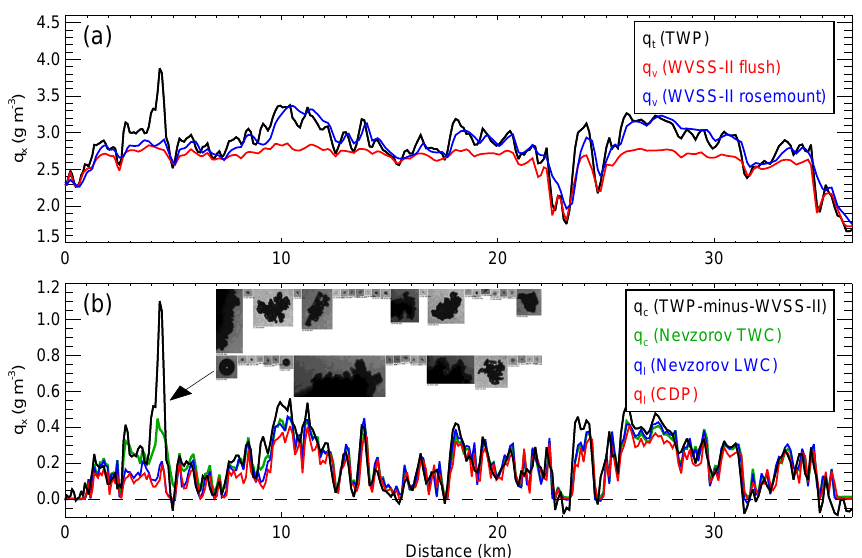
Figure 1. Example data from flight B668 in stratocumulus cloud at a temperature of − 9 ◦ C. Panel (a) shows the measured q t from the total water probe, q v from both WVSS-II instruments. Panel (b) shows the measured q c from the Nevzorov probe and from the TWP-minus- WVSS-II (flush inlet) method. Also included are measurements of liquid water content from the CDP and Nevzorov q l sensor. Example CPI imagery in a region containing ice particles is also